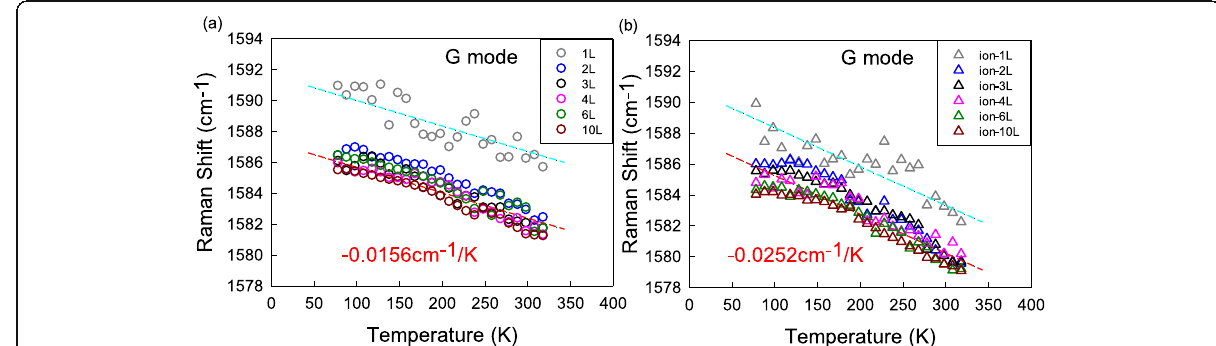
Fig. 3 The T-dependent Pos(G) of 1LG-4LG, 6LG, and 10LG for a defect-free and b defective sets in the temperature range of 78 – 318